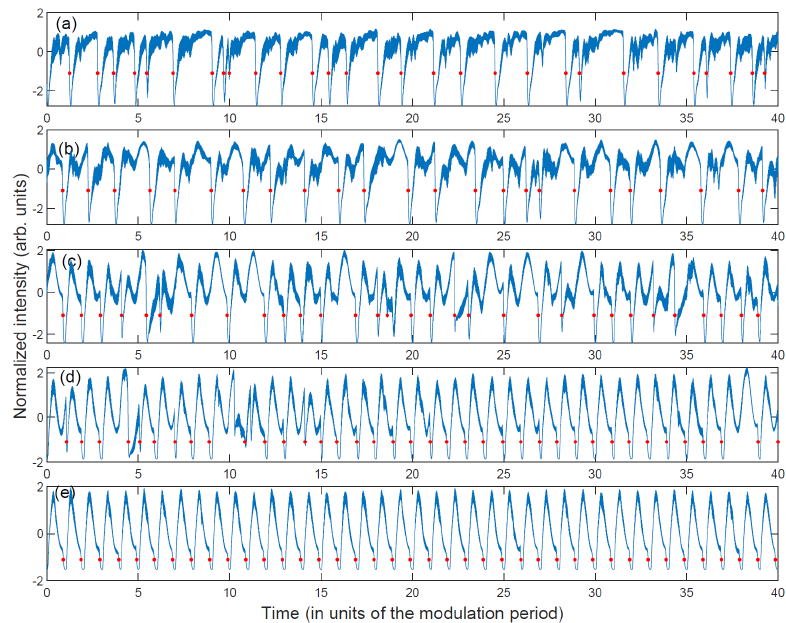
Figure 3. Intensity time series for increasing modulation amplitude: a mod = 0 ( a ), 0.01 ( b ), 0.025 ( c ), 0.04 ( d ), 0.05 ( e ). f mod = 5 MHz; other parameters are as indicated in the text.